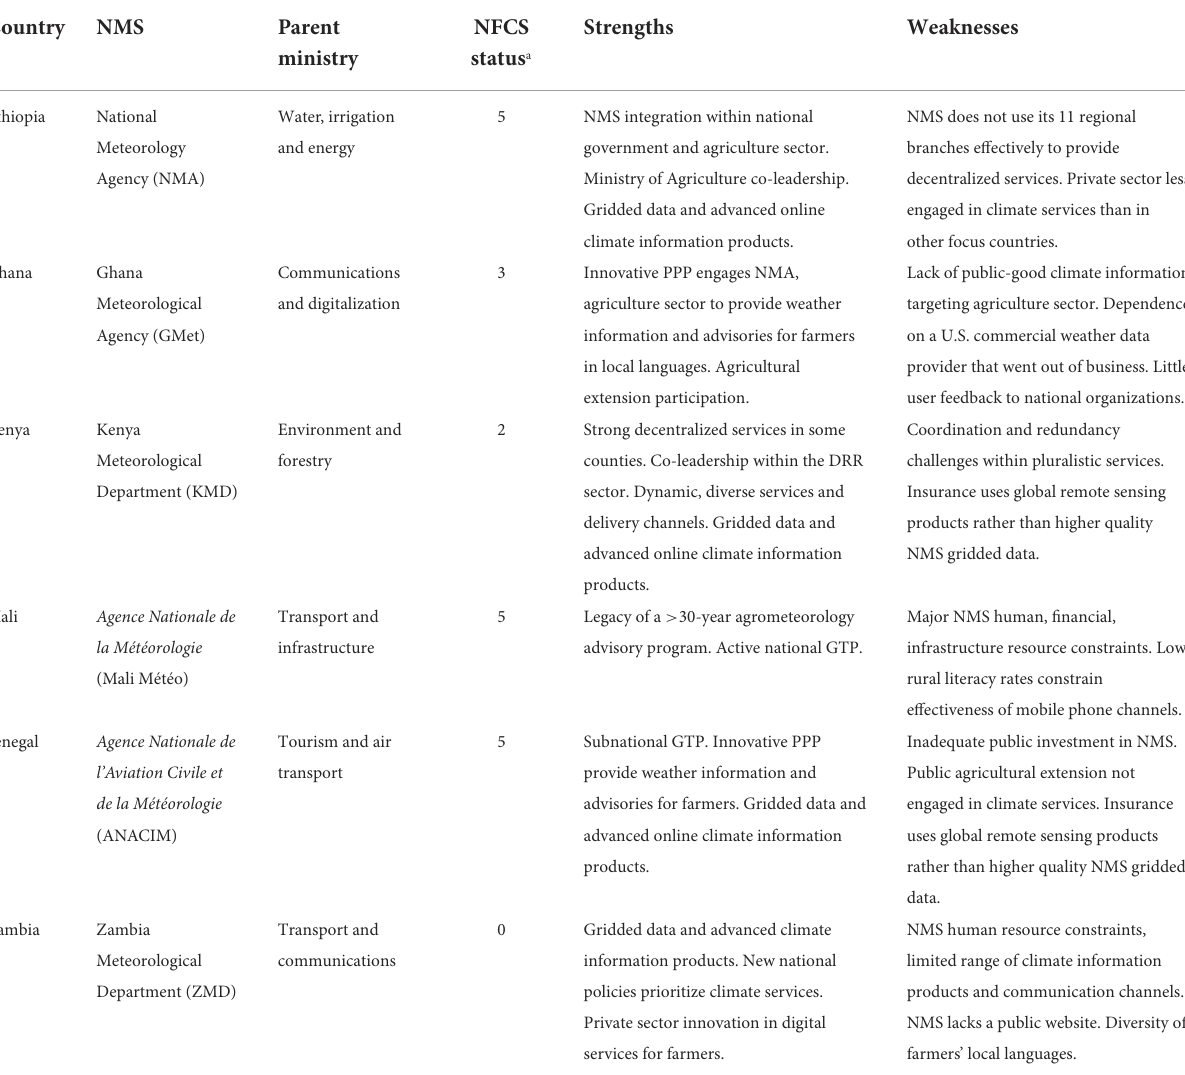
TABLE 2 Key features, strengths and weaknesses of agricultural climate services in focus countries. Country NMS